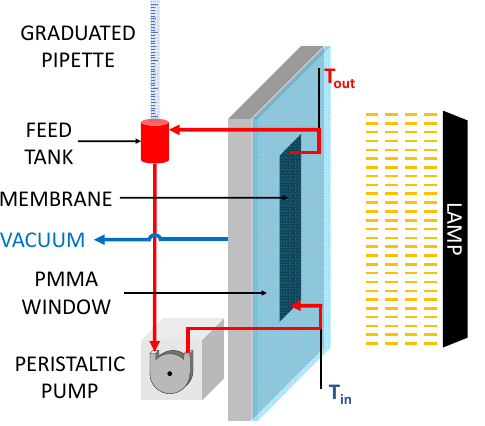
MEMBRANE MEMBRANE